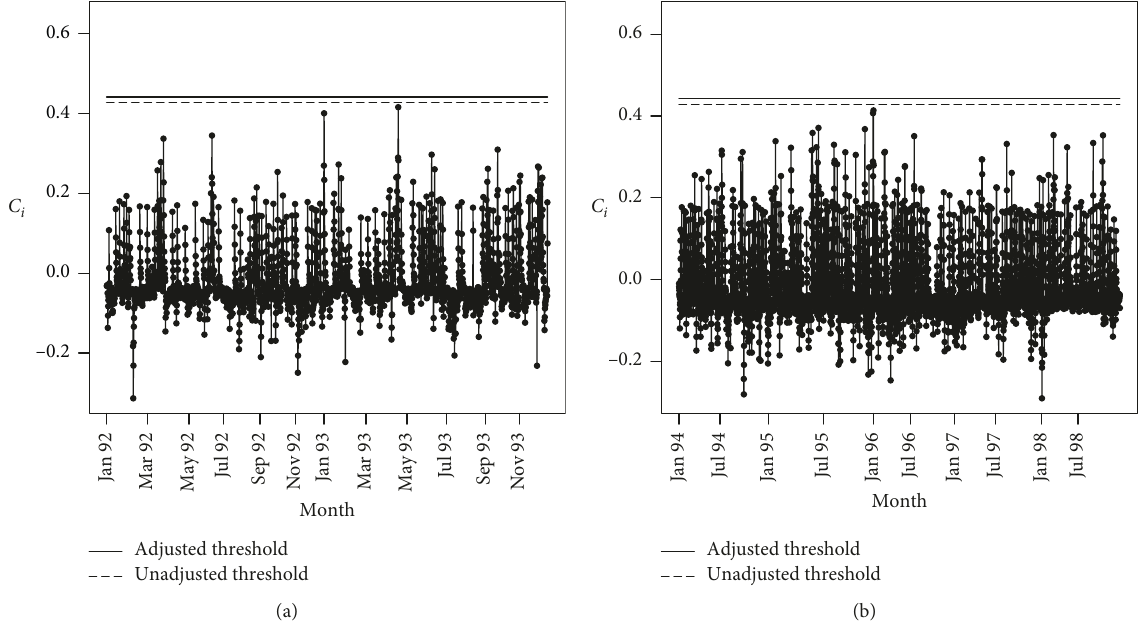
Figure 12: RA-EWMA chart for Phase-I and Phase-II assuming first two years as the Phase-I for 30 days mortality of cardiac surgery patients. (a) Phase-I chart, unadjusted UCL � 0.4281 and adjusted UCL � 0.4417. (b) Phase-II chart, unadjusted UCL � 0.4281 and adjusted UCL � 0.4417.